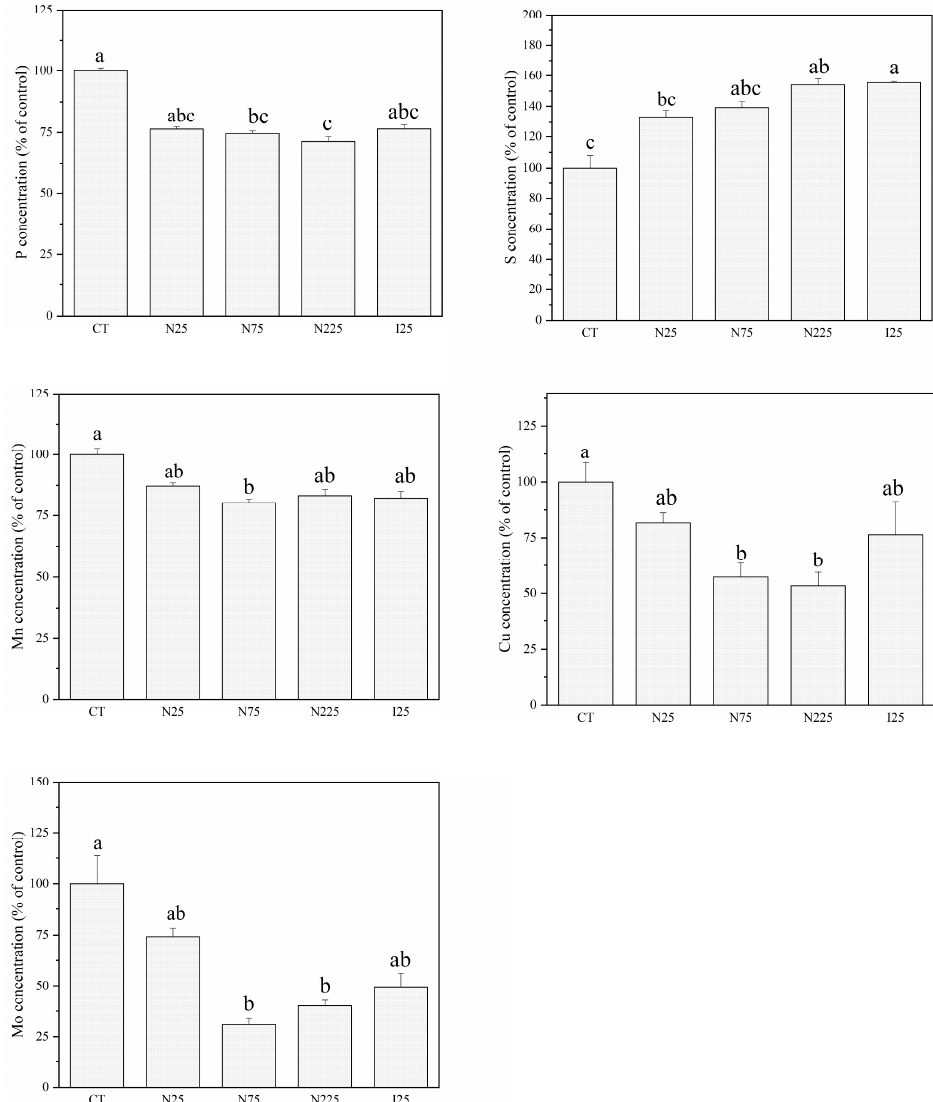
Figure 5. Contents of P, S, Mn, Cu, and Mo in the soybean seeds harvested from plants cultivated in CeO 2 NPs/CeCl 3 -amended soil. CT: control; N: CeO 2 NPs; I: CeCl 3 . Different letters stand for statistical differences between treatments at p ≤